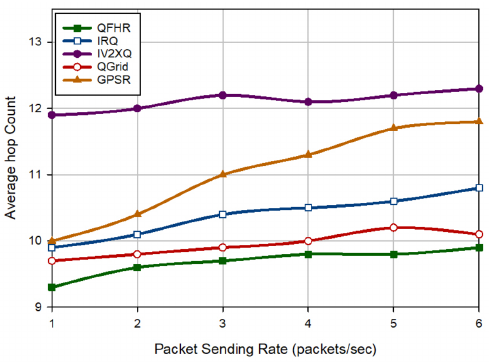
Figure 14. Average number of hops in different approaches with regard to PSR.